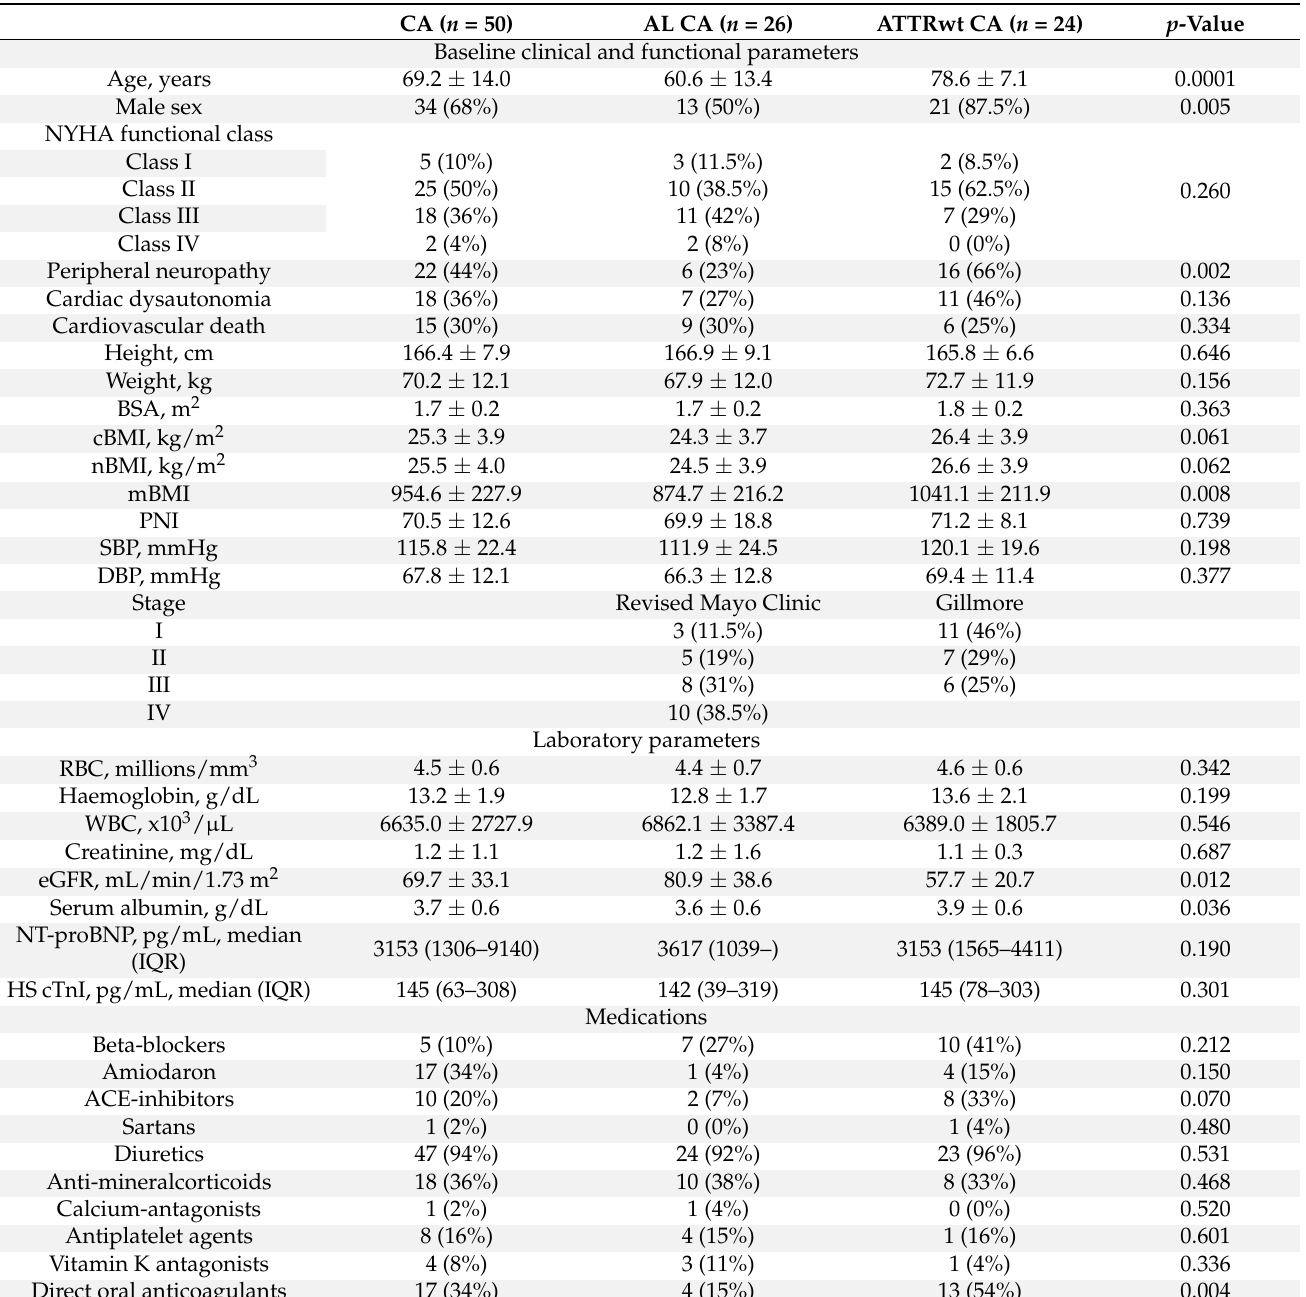
Table 1. Clinical characteristics of the study cohort. Data are presented in mean ± SD or n (%), unless otherwise